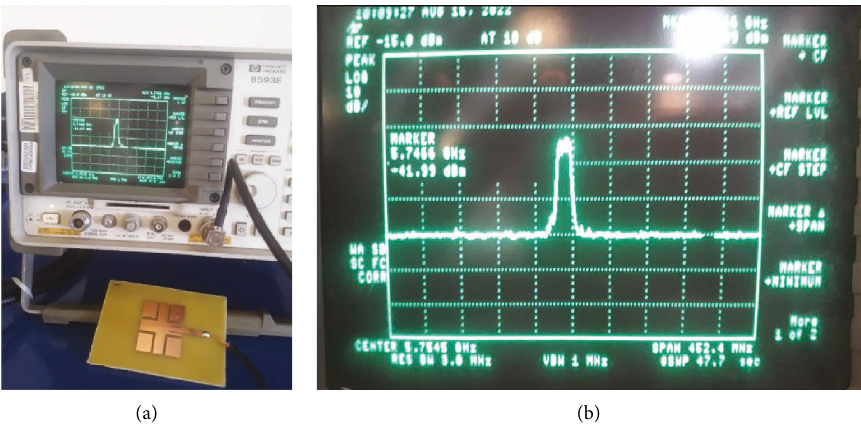
Figure 16: Measurement setup for the proposed